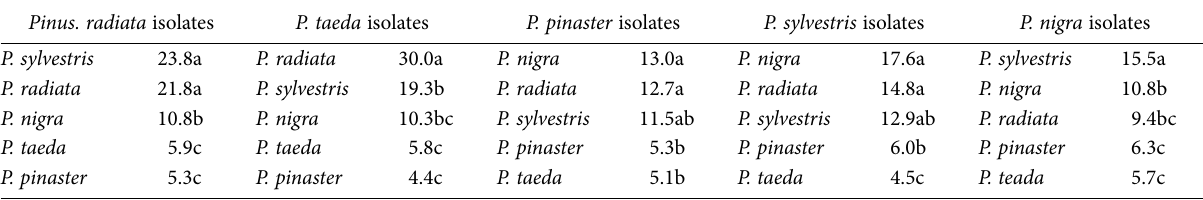
Table 9. Results of Diplodia sapinea cross inoculation of twigs. Pinus. radiata